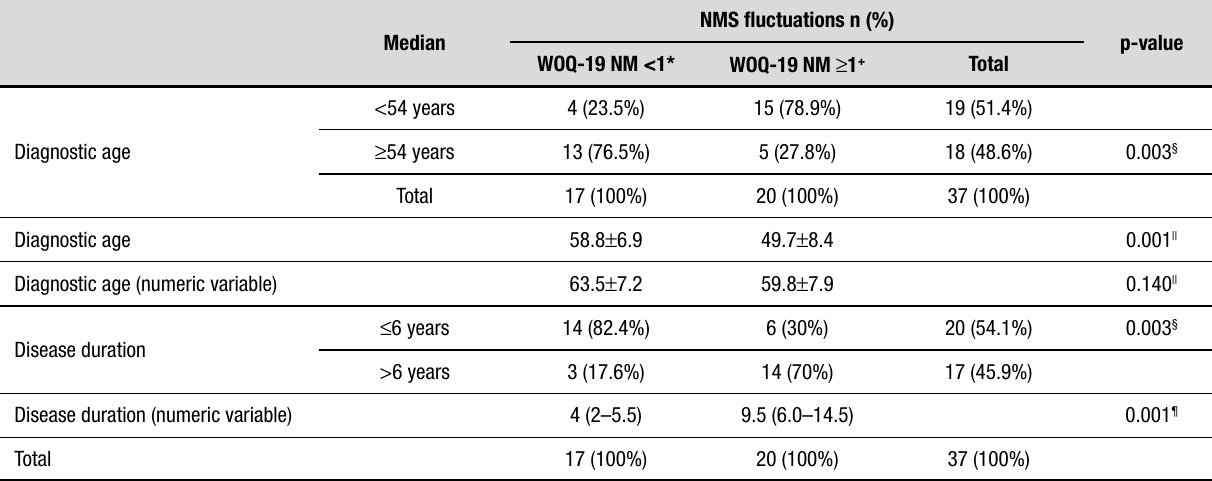
Table 3. Comparison of the frequency of non-motor symptoms fluctuation between groups divided by the median age at diagnosis and disease duration.